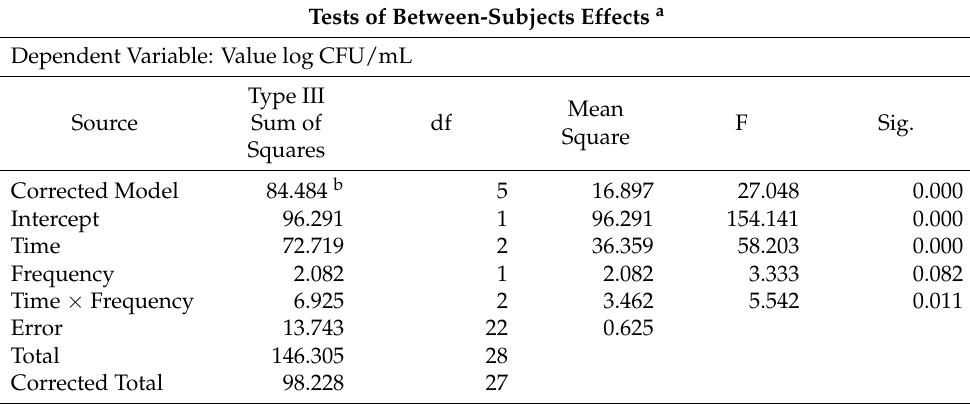
Table 2. Two-way ANOVA results of whole egg samples considering treatment time and frequency. Tests of Between-Subjects Effects a